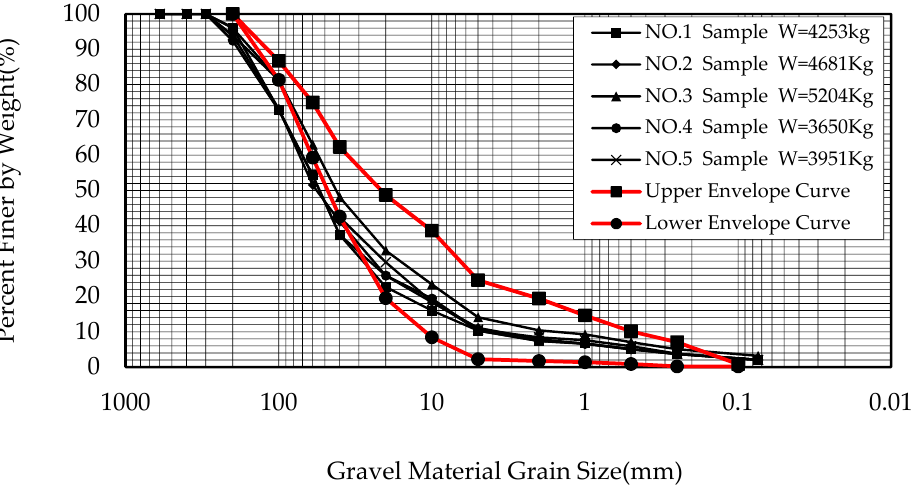
Figure 11. Grading curve of gravel material taken from in situ VI zone material field.